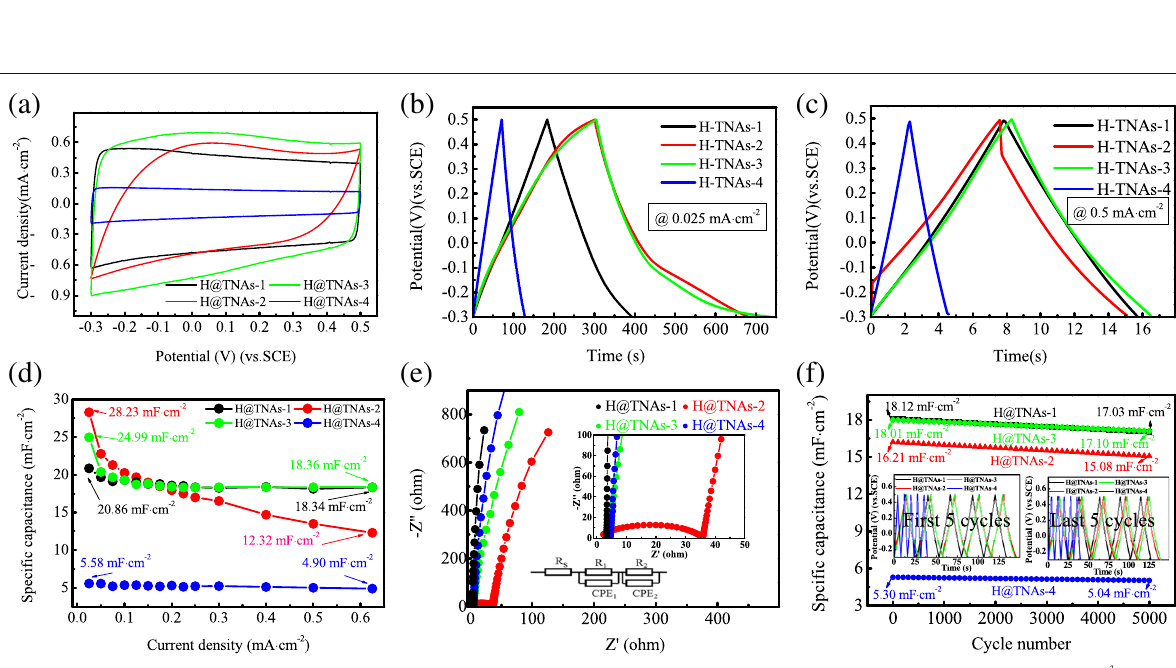
Fig. 11 Supercapacitive properties of oriented H@TNAs with mixed crystal structures. a CV curves collected at the scan rate of 100 mV s − 1 . Galvanostatic charge/discharge curves at current densities of b 0.025 and c 0.5 mA cm − 2 . d Specific capacitance of as-prepared H@TNAs measured as a function of current density. e Nyquist plots of as-prepared H@TNAs. f Cyclic performance of as-prepared H@TNAs, insets are the galvanostatic charge/discharge curves of the first 5 cycles and the last 5